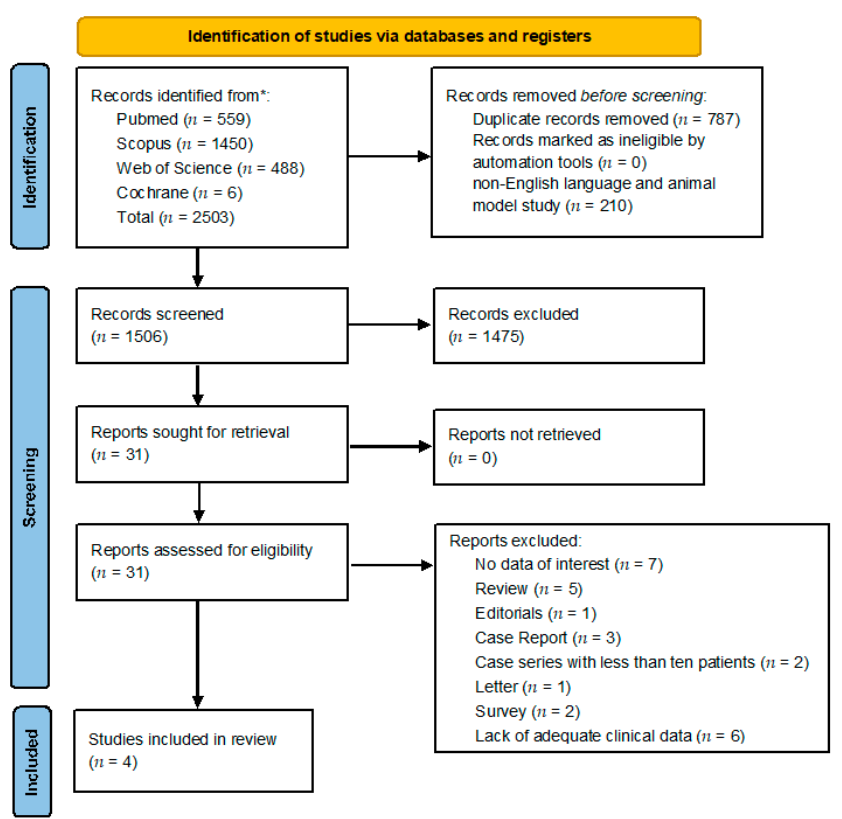
Figure 1. PRISMA [19] diagram resembling electronic database search and inclusion/exclusion pro ‐ cess of the review. Legend * date of last search 5 October 2022. process of the review. Legend * date of last search 5 October